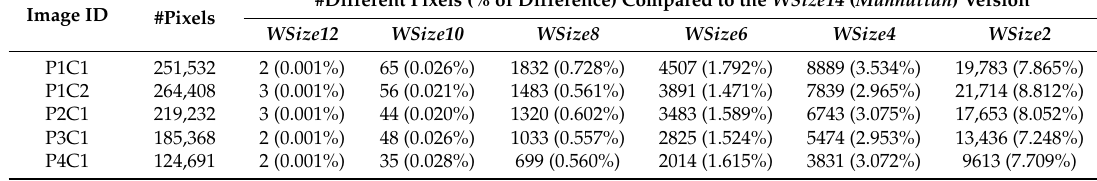
Table 7. Number of pixels with different classification results using the Manhattan distance between the computed window sizes and the WSize14